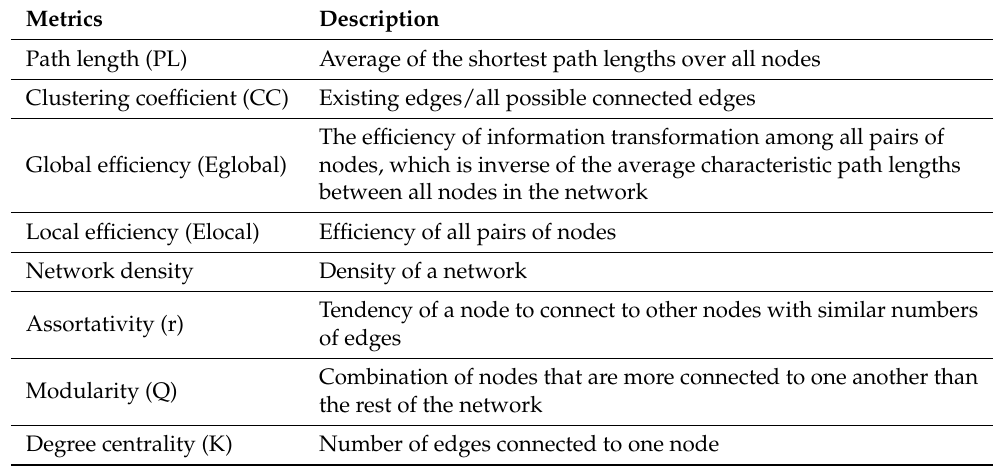
Table 1. Network